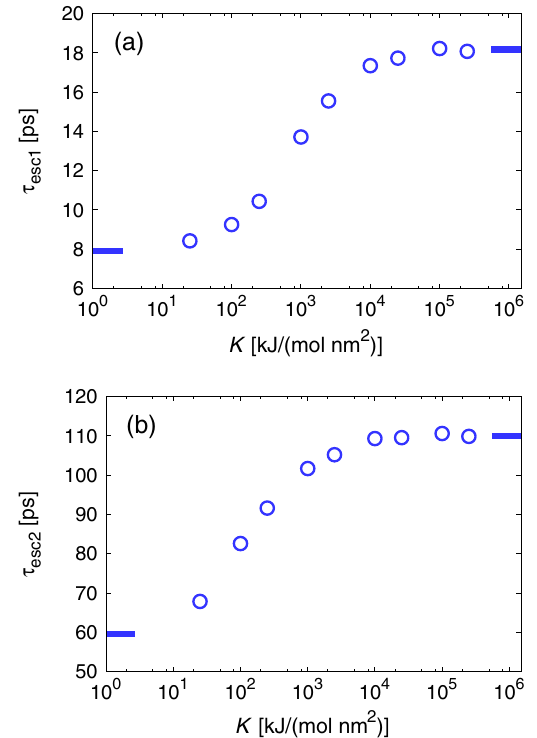
FIG. 5. Mean escape times of water from the first hydration shell around methane. (a) Results for τ , defined as the mean esc 1 first passage time from r ¼ 0 . 37 nm to a target distance of r ¼ 0 . 65 nm [indicated by dashed vertical lines in the RDF in Fig. 1(b)], are shown as a function of K . Results in the limits K ¼ 0 and K ¼ ∞ are denoted by horizontal lines. (b) The mean escape time τ from r ¼ 0 . 37 nm to a target distance of esc 2 r ¼ 1 . 37 nm as a function of K